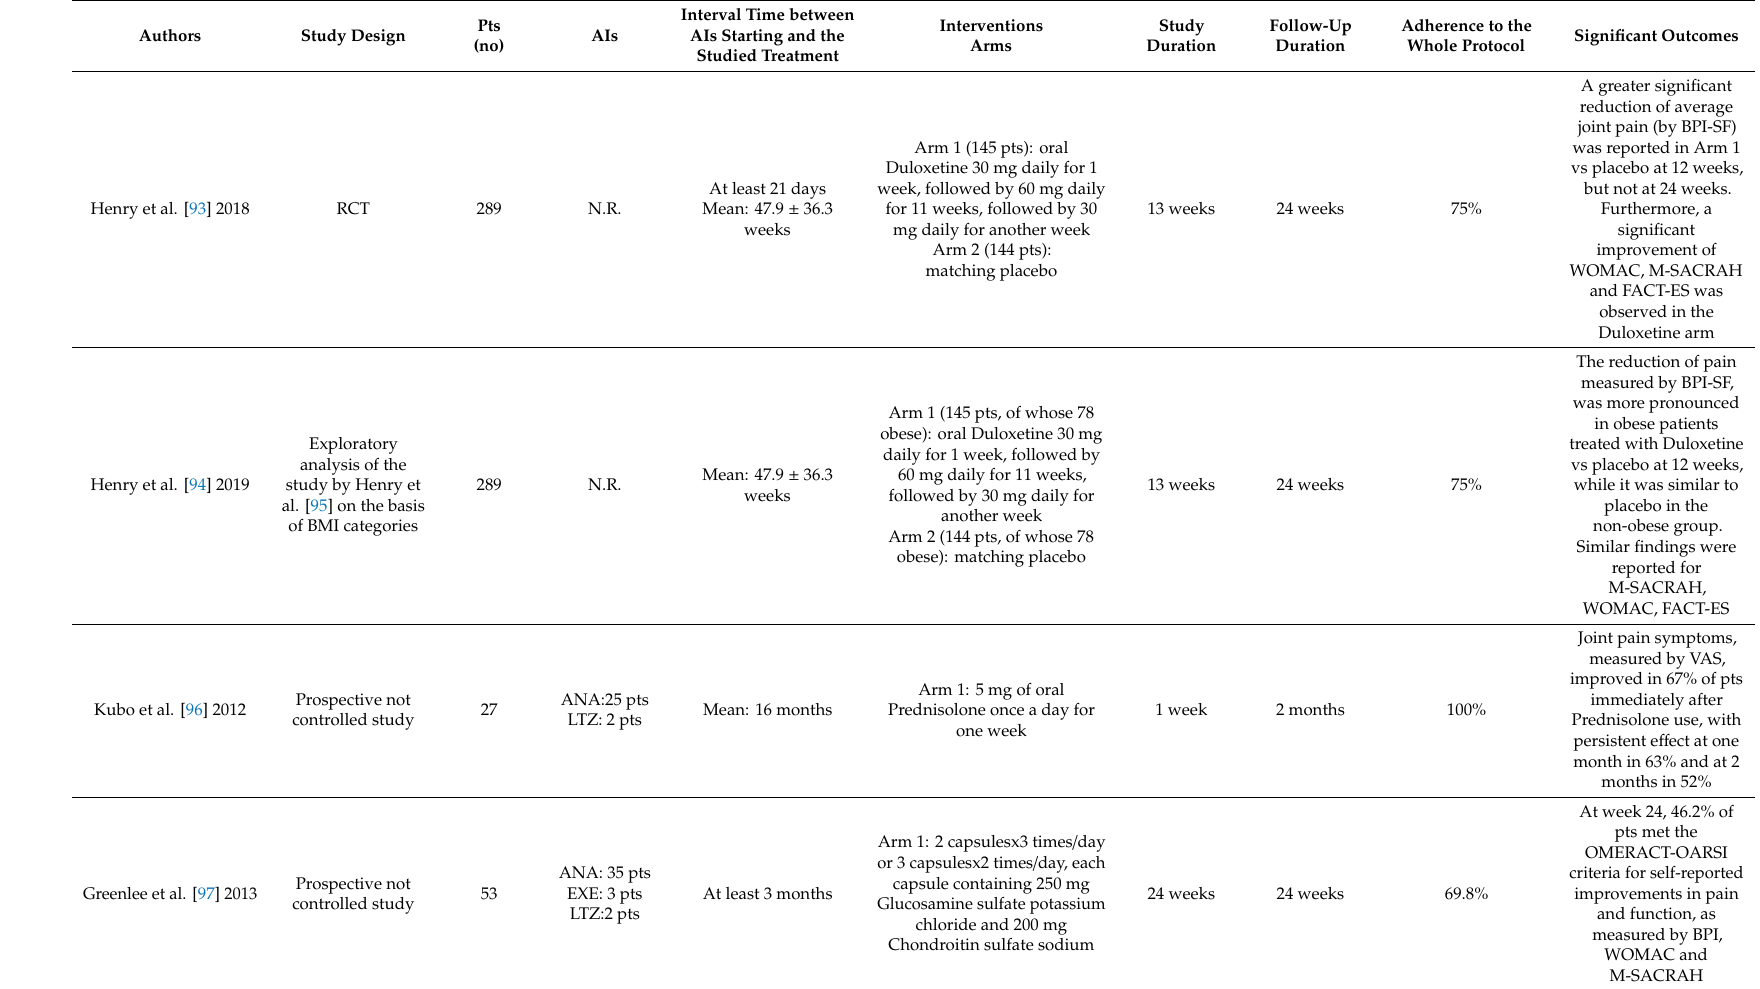
Arm 1: 5 mg of oral Prednisolone once a day